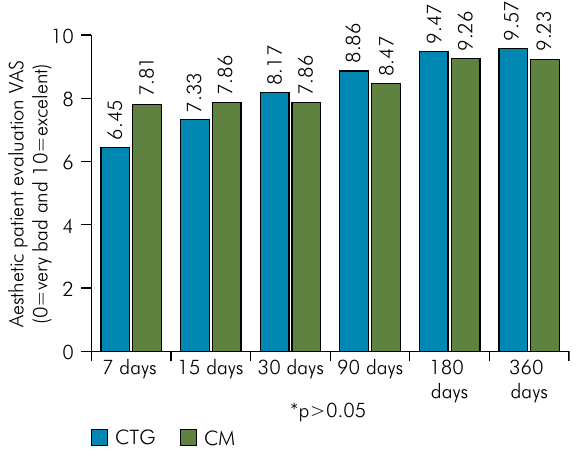
Figure 4. Aesthetic periodontist evaluation VAS (0= very bad and